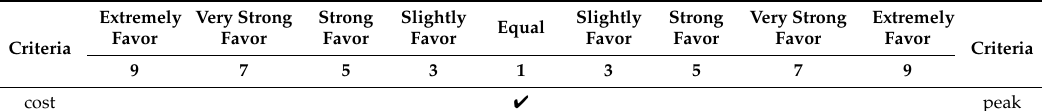
Table 1. First evaluators’ comparison according to Saaty’s scale.